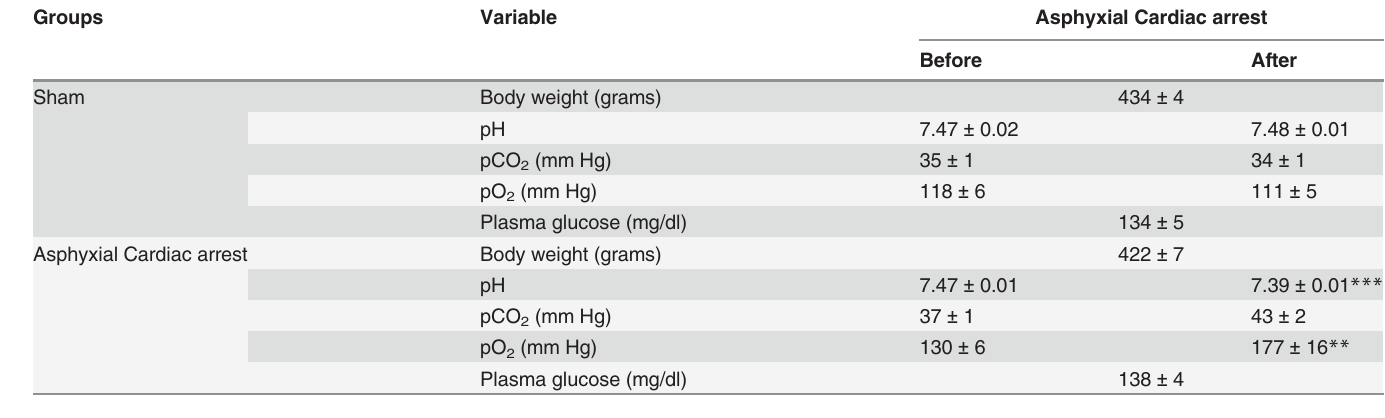
Groups Variable Asphyxial Cardiac arrest